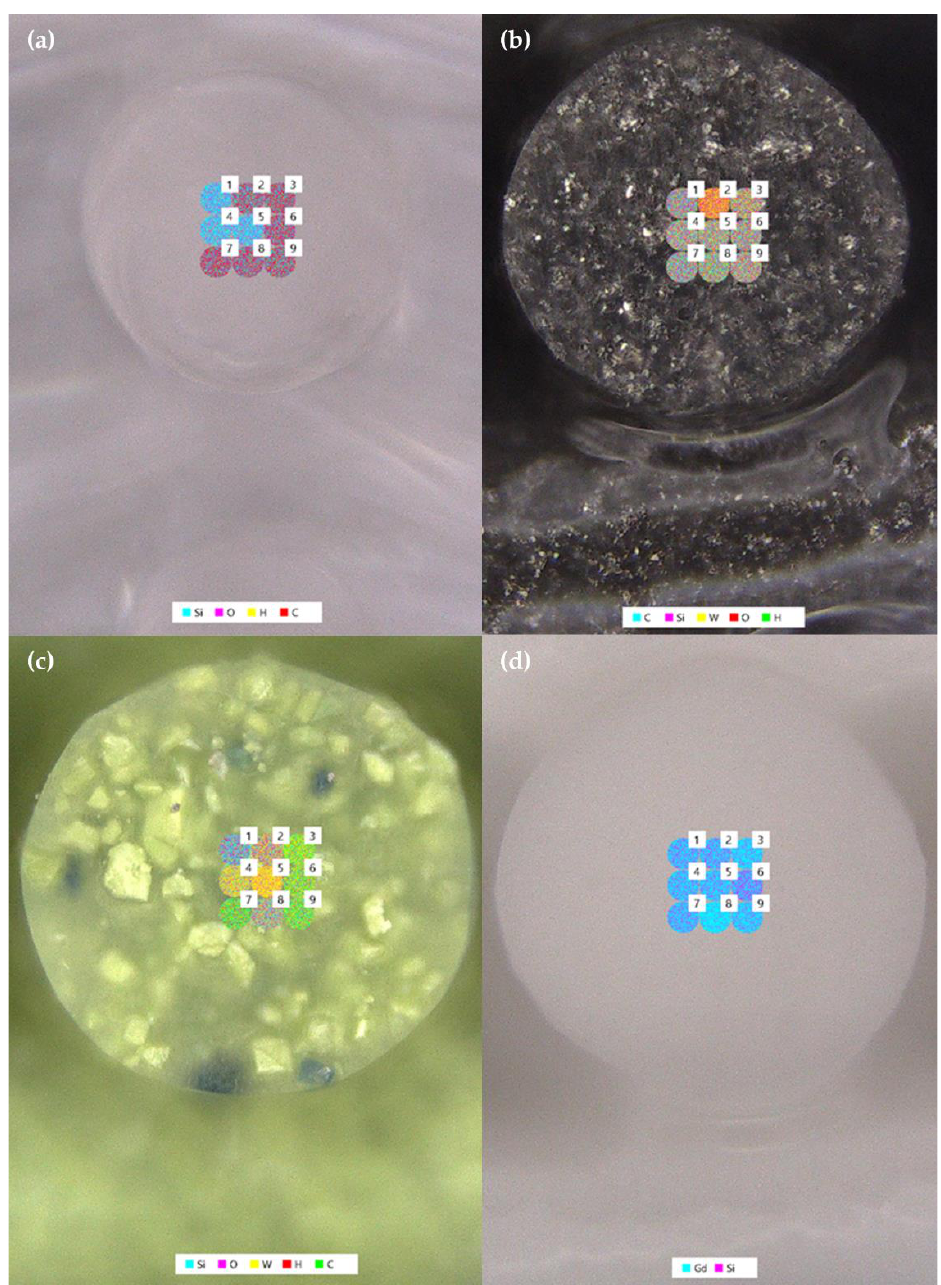
Figure 12. Microscope images and elemental maps of DIW prints made with: ( a ) A300 ink, ( b ) 60 wt% W ink, ( c ) 60 wt% WO 3 ink, and ( d ) 60 wt% Gd 2 O 3 ink. W ink, ( c ) 60 wt% WO 3 ink, and ( d ) 60 wt% Gd 2 O 3